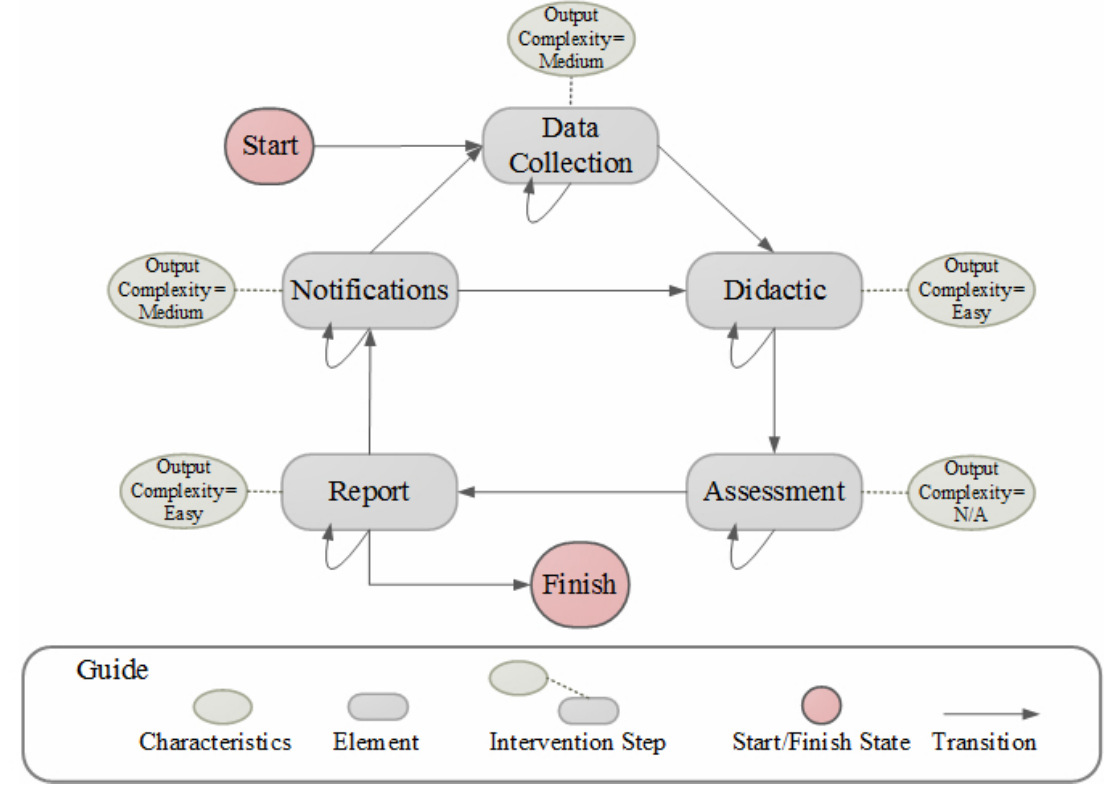
Figure 5. Example workflow generated by the workflow-planner specifying the elements (rectangular nodes), element’s characteristics (elliptical nodes), as well as order of transitions among elements.